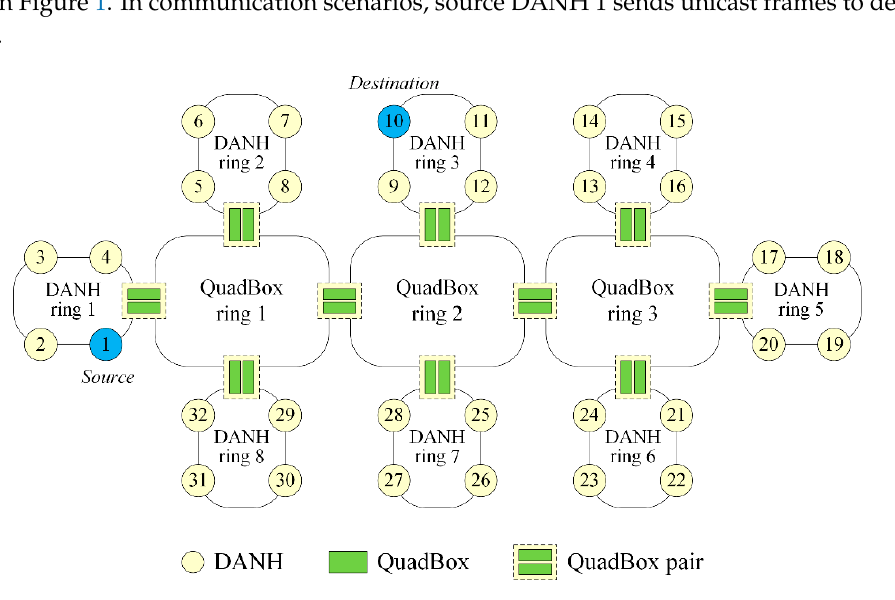
Figure 1. Sample HSR network. HSR: high-availability seamless redundancy; DANH: doubly-attached nodes with HSR protocol.